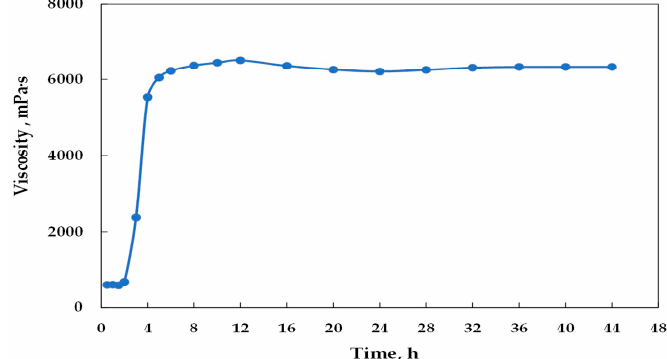
Figure 4. The change curve of gel viscosity with time.